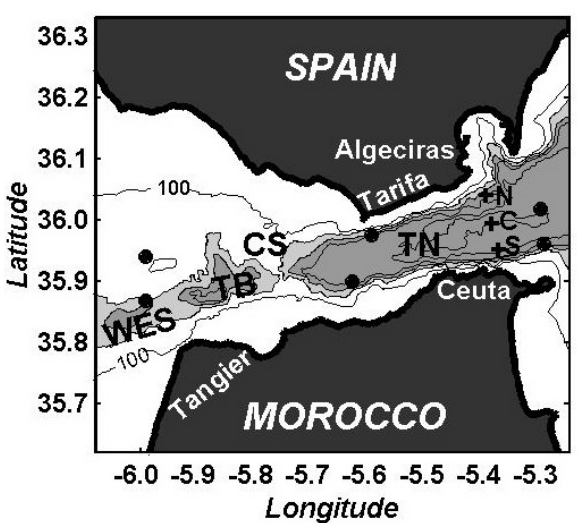
F IG . 1. – Map of the Strait of Gibraltar showing the location of the most outstanding topographic features. From left to right they are: West Espartel Sill (WES), Tangier Basin (TB), Camarinal Sill (CS) and Tarifa Narrows (TN). Crosses labelled “N”,”C”, and “S” at the eastern section indicate the samplings sites occupied during CANI- GO from which the seasonal signals in the exchanged flows were estimated in